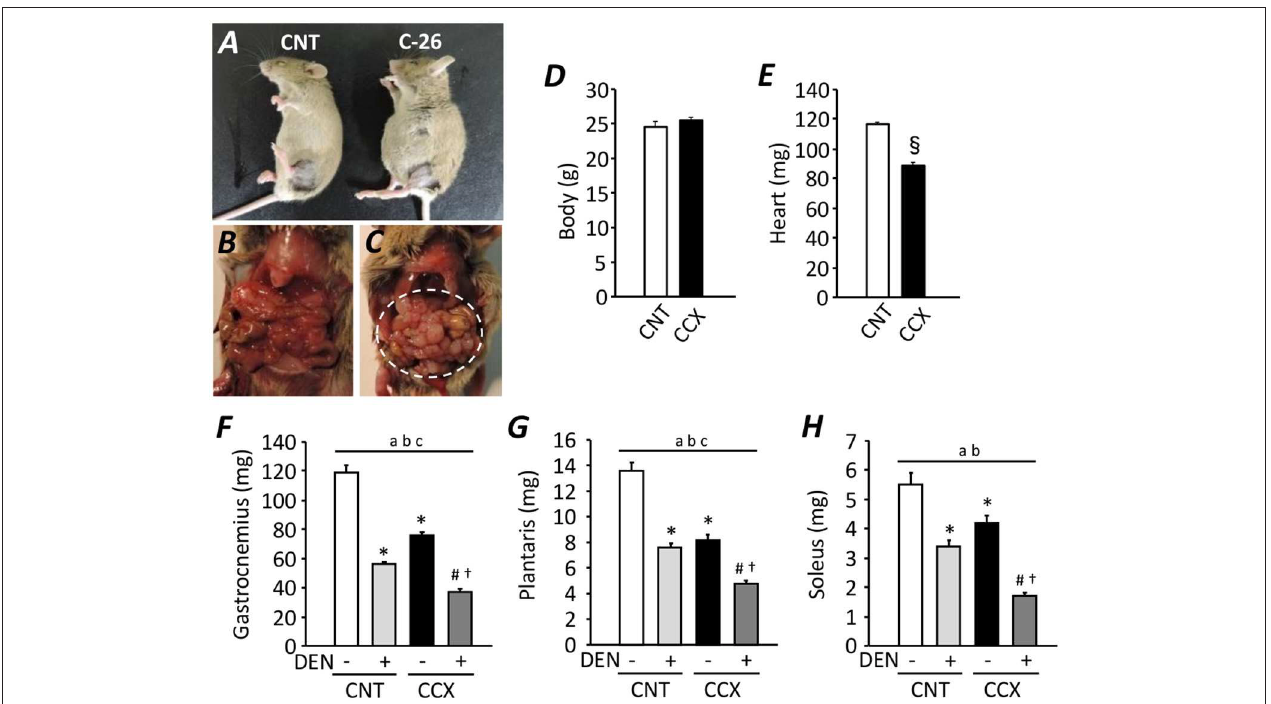
FIGURE 1 | Cancer cachexia exacerbates atrophy in denervated mouse skeletal muscles. Photographs of anesthetized control (CNT) and cancer cachexia (CCX) mice (A) . Images after mouse laparotomy in CNT (B) and CCX mice (C) . Note that CCX mice showed extensive intraperitoneal tumor growth (dotted circle). The body (D) and heart (E) weight in each group. Bars show the mean and SEM results from 6 to 7 mice per group. § P < 0.05 vs. CNT. The muscle wet weight of fast-twitch gastrocnemius (F) and plantaris muscles (G) and slow-twitch soleus muscles (H) from CNT and CCX mice, with or without denervation (DEN). Bars show the mean and SEM results from 6 to 7 muscles per group. Statistical significance was set at P < 0.05: main effect of a CCX and b DEN; c interaction of CCX and DEN; difference vs. *CNT without DEN, # CNT with DEN, and † CCX without DEN.